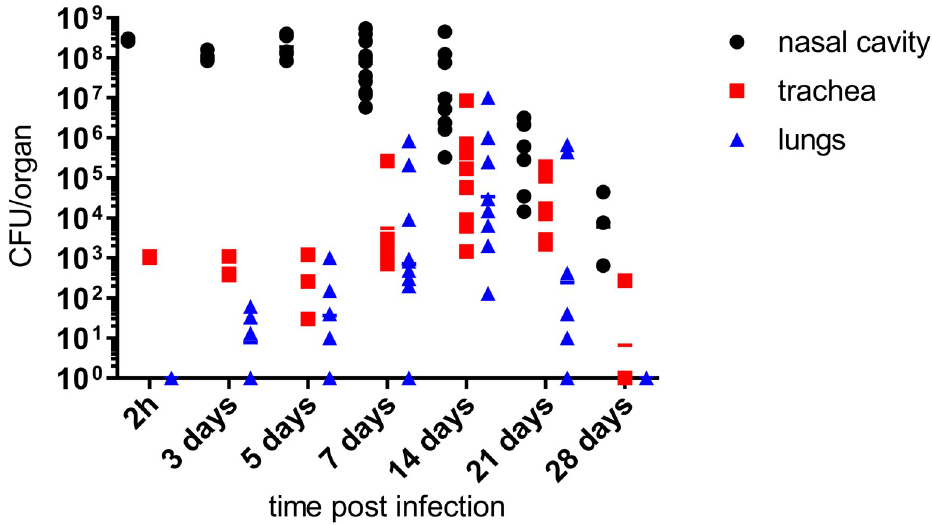
Fig 12. B . pertussis rhinosinusitis eventually leads to lung infection. Nares of MyD88 KO mice were inoculated with 10 9 CFU of B . pertussis applied in 5 μ l of suspension to prevent inhalation into lungs. At indicated time points the mice were sacrificed and bacterial loads in the nasal cavity, trachea and lungs were determined by plating of organ homogenates on BG agar. Three mice per time points of 2 h and 28 days were used and 5 to 12 mice were used for other time points. Data for days 7, 14 and 21 were pooled from two independent experiments and the lines correspond to geometric